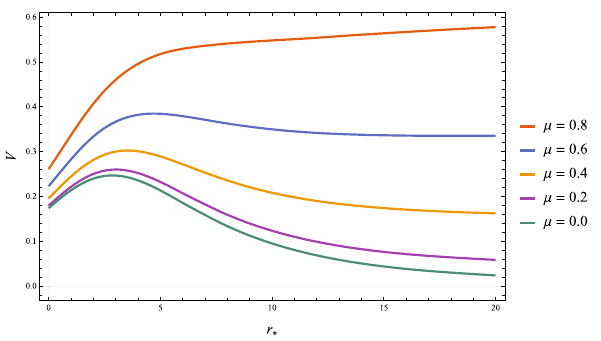
Fig. 3 The ( n ,(cid:4)) = ( 0 , 2 ) mode of the scalar potential of Eq. (2.48) for increasing values of the parameter μ . Note that for μ = 0, V → 0 as r ∗ → ∞ and the effective potential has a distinct peak. For μ (cid:6)= 0, V → μ 2 as r ∗ → +∞ . When μ 2 (cid:2) V ( r 0 ) , the peak is smoothed and